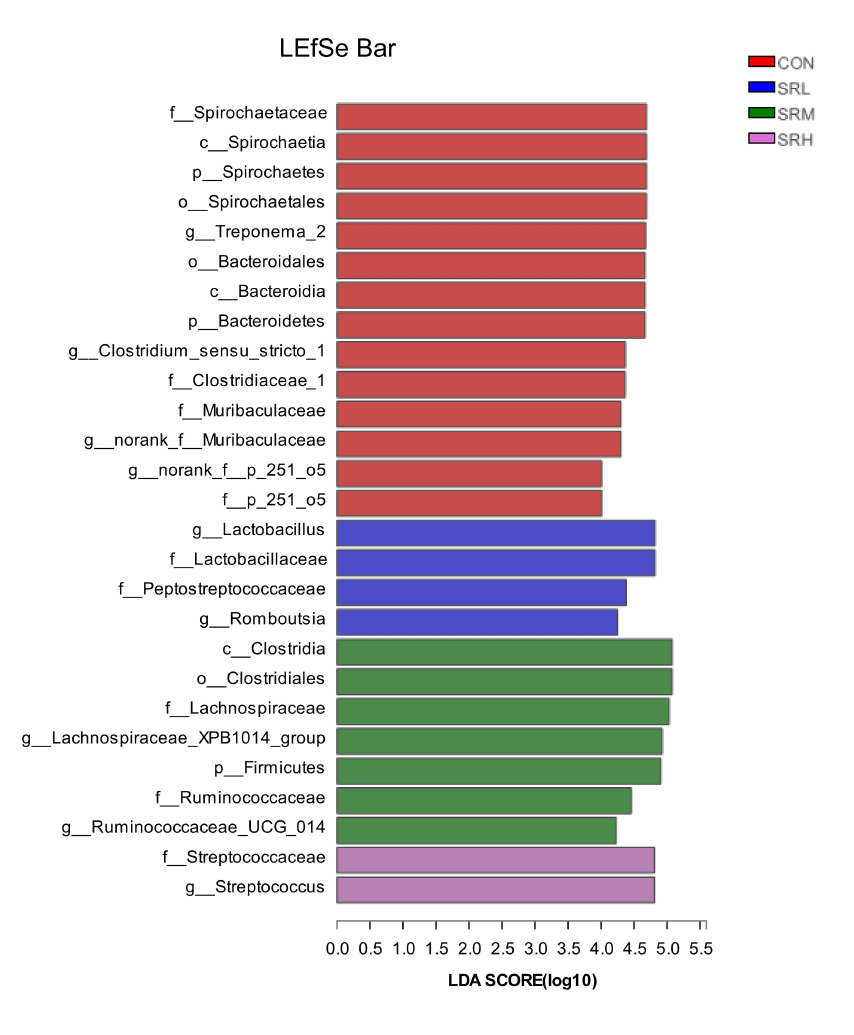
Figure 11. Histogram of the linear discriminant analysis (LDA) value